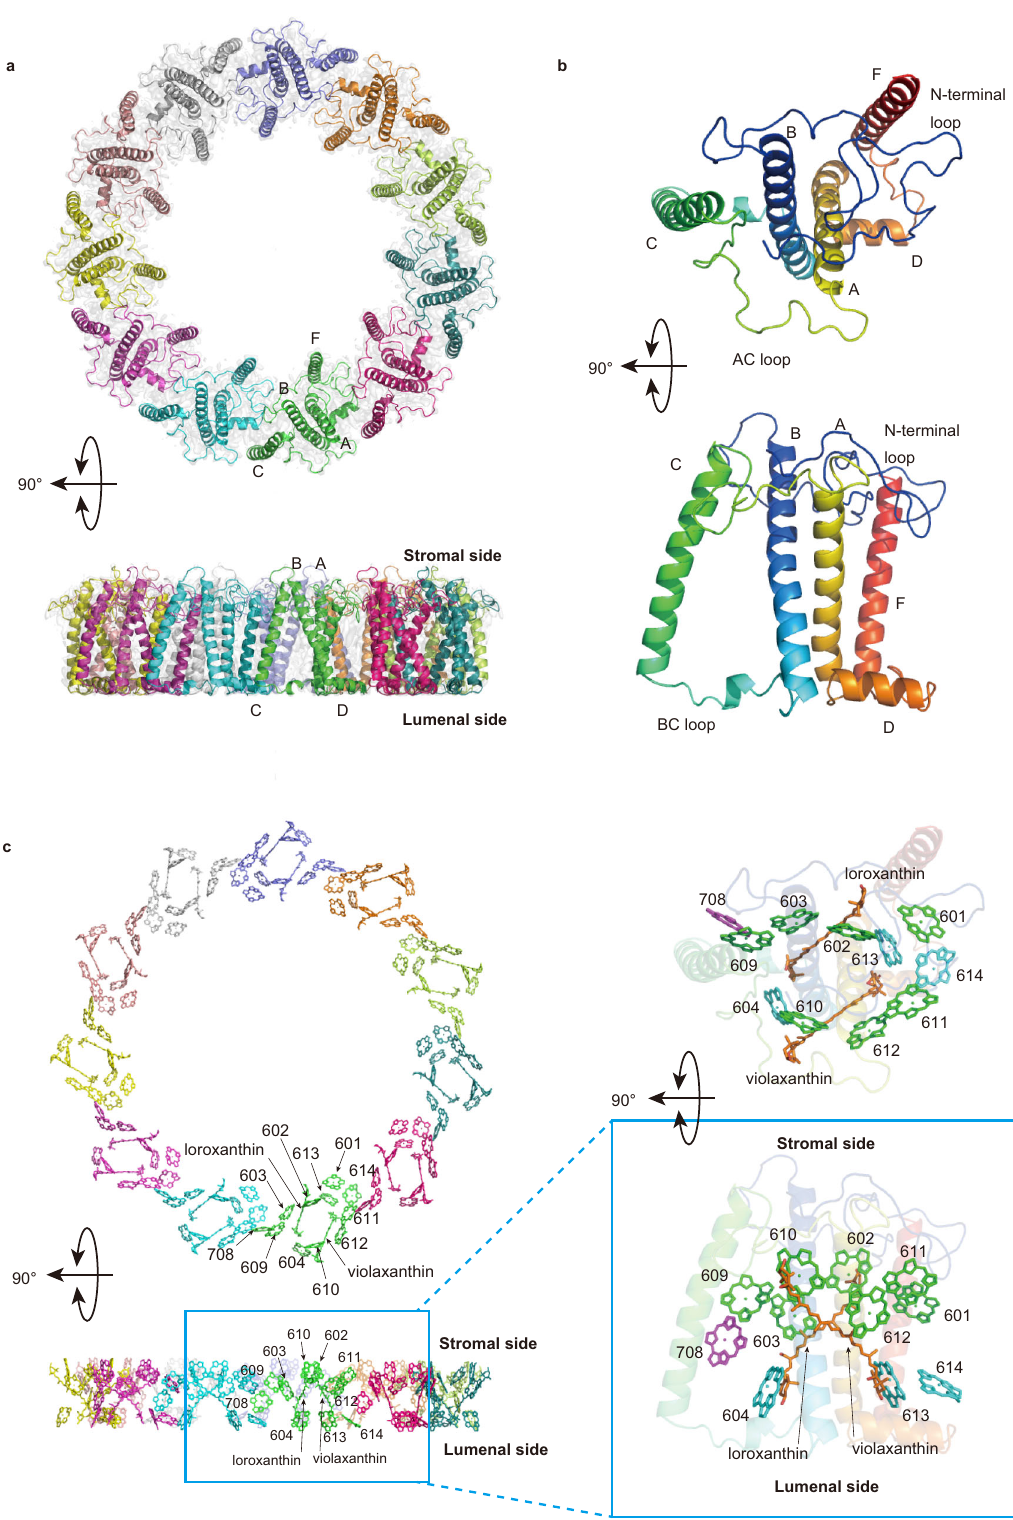
Fig.5|Overallcryo-EMstructureofPc-frLHC.a Top(upperpanel)andside(lower panel)viewsfromthestromalsideandoutsideoftheundecamerring,respectively, of Pc-frLHC are shown with the cryo-EM map. Each subunit is shown in a different color. b Top and side views (the same views as in ( a )) of the subunit of Pc-frLHC in rainbow colorsfrom the N-terminus in blue to the C-terminusinred. c Chlorophyll